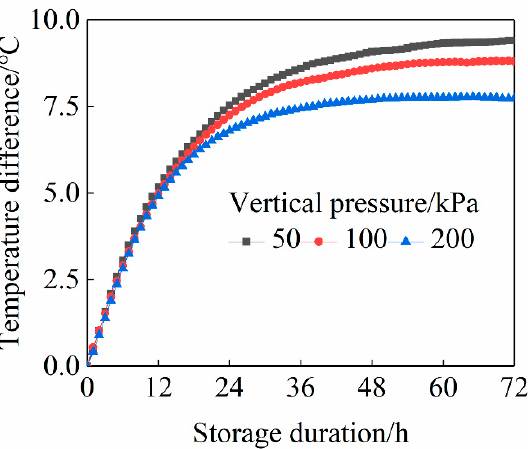
Figure 4. Temperature difference of middle plane and near low-temperature boundary wall under different pressures.